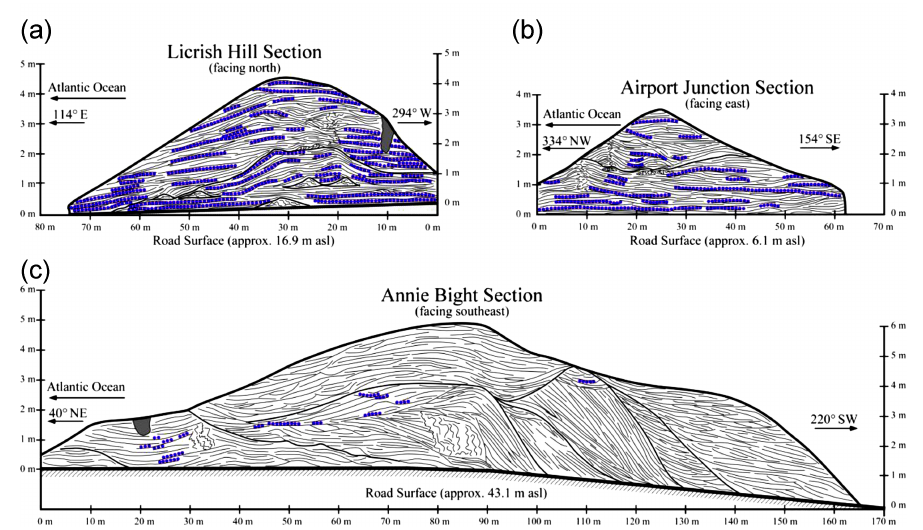
Figure 24. Cross-section diagrams (Tormey, 1999) of Eemian chevron and dune deposits in North Eleuthera ( a, b ∼ 10km west of megaboul- ders) showing geometry of bedding, fenestral porosity (lines of blue dots), and fossil roots (vertical wavy lines). (a) Chevron ridge exposure at Licrish Hill characterized by rising sequences of thick, tabular fenestral beds. (b) Chevron ridge exposure at Airport Junction characterized by rising sequences of thick, tabular fenestral beds. (c) Eolian ridge exposure at a higher elevation road cutting at Annie Bight (6km south of megaboulders) characterized by dominantly backset and topset bedding with scattered, thin, wispy fenestrae